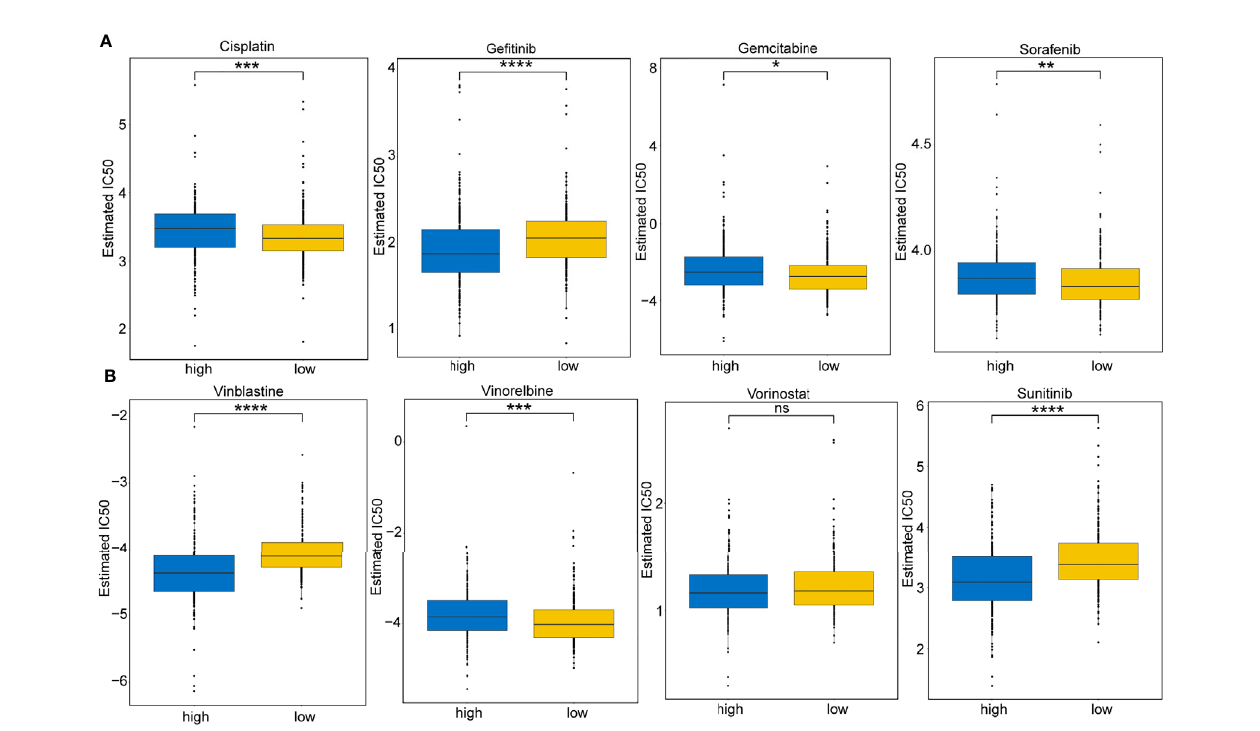
FIGURE 11 | Immunotherapeutic and chemotherapeutic responses for high- and low-risk patients. (A) Boxplots illustrate the immunotherapeutic and chemotherapeutic responses of Cisplatin, Ge fi tinib, Gemcitabine, and Sorafenib in the high- and low-risk patients. (B) Boxplots illustrate the immunotherapeutic and chemotherapeutic responses of Vinblastine, Vinorelbine, Vorinostat, and Sunitinib in the high- and low-risk patients. Signi fi cance: ns ≥ 0.05, ∗ <0.05, ∗∗ <0.01, ∗∗∗ <0.001, and ∗∗∗∗